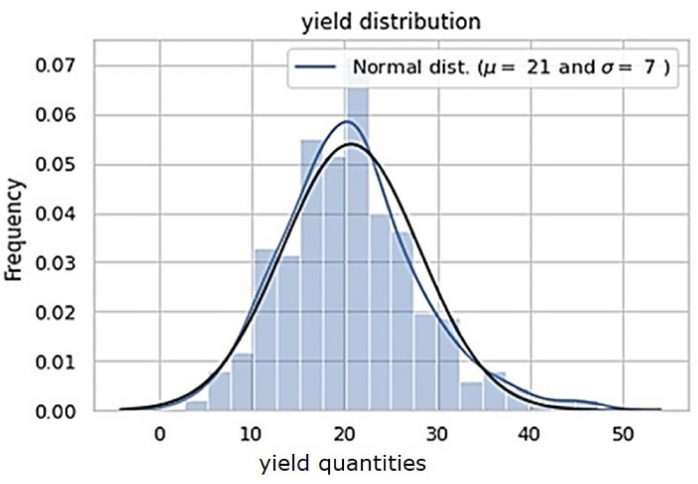
Figure 3. Distribution of the